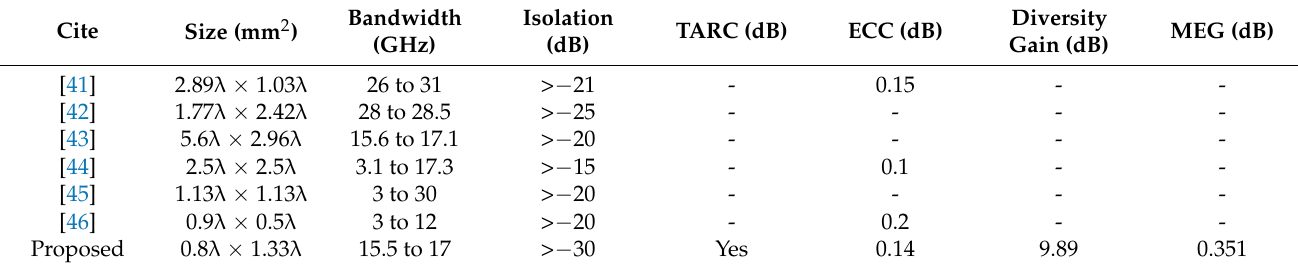
Table 3. Comparison between the proposed and existing MIMO antennas.